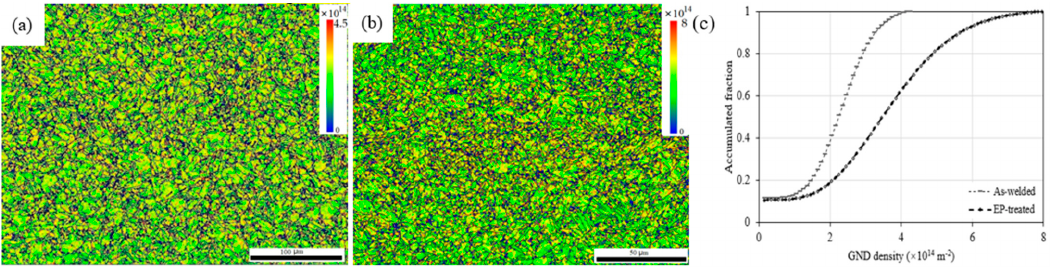
Figure 8. GND mapping of the ( a ) as-welded, ( b ) EP-treated and ( c ) accumulated fraction.